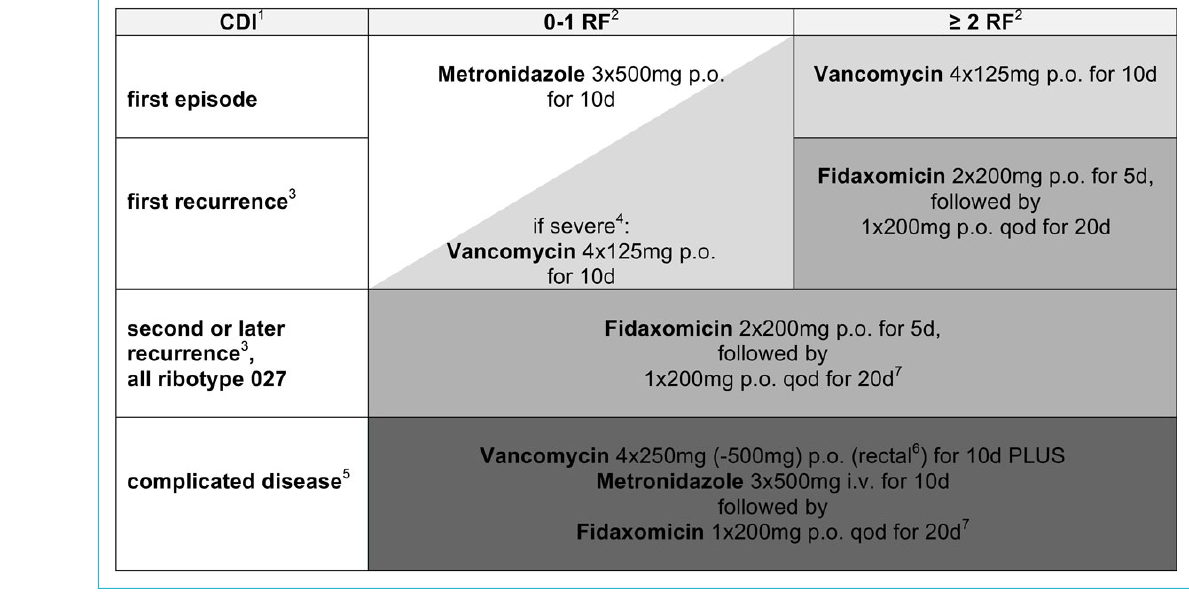
Figure 4: In-house treatment algorithm for Clostridioides difficile infections according to number of episode/recurrence, risk factors for recur- rence and severity of disease. 1 CDI = Clostridioides difficile infection. 2 RF = risk factors for recurrence: age >70 years, severe comorbidity / haematological malignancy, chronic kidney disease stage ≥4, severe CDI, continued antibiotics other than for CDI, proton pump inhibitor use. 3 Occurring within a follow-up of 60 days. 4 Defined by ≥2 indicators for severe CDI: temperature ≥38.5°C, peritonism, leucocytes >15 × 10 9 /l, creatinine increase ≥1.5 times baseline, albumin <25 g/l. 5 Complicated (also fulminant): severe CDI PLUS ileus and/or severe sepsis and/or lactate >5 mmol/l. 6 In cases of (sub)ileus. 7 For recurrence after tapered fidaxomicin therapy or after complicated disease consider bezlotoxum- ab or faecal microbiota transplantation in outpatient